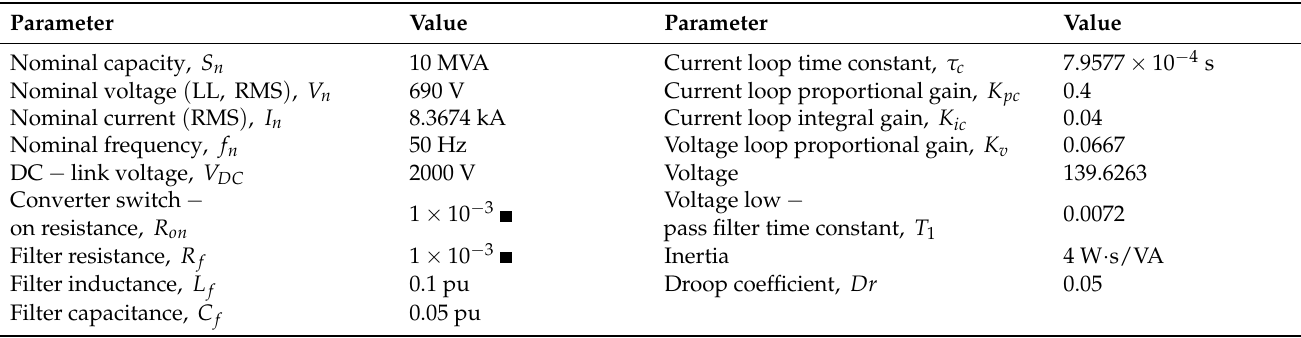
Table A4. Parameters of the GSC control scheme.